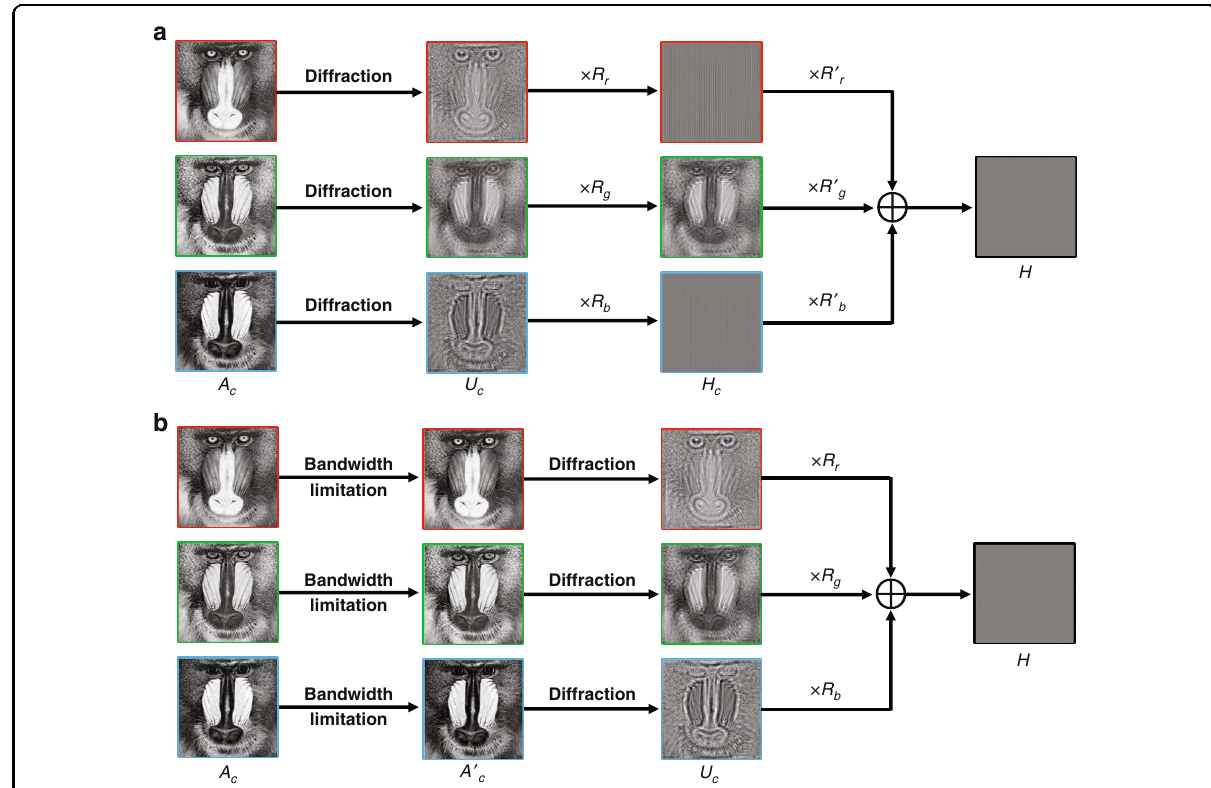
Fig. 10 Flowchart of CMC methods. a The method in ref. 152 , where c = r, g, b corresponds to RGB channel, A c is the target image, U c is the diffraction pattern of A c , R c = exp(jk c xsin θ c ) is the tilted plane reference light along x axis, H c = U c × R c is the off-axis hologram, R' c = exp(jk c ysin θ ) is the titled plane reference light along y axis, and H is the complex CMH; b The method in ref. 157 , where A' c is the target image after bandwidth limitation, U c is the diffraction pattern of A' c , R c = exp(jk c ysin θ ) is the titled plane reference light along y axis, and H is the complex rainbow